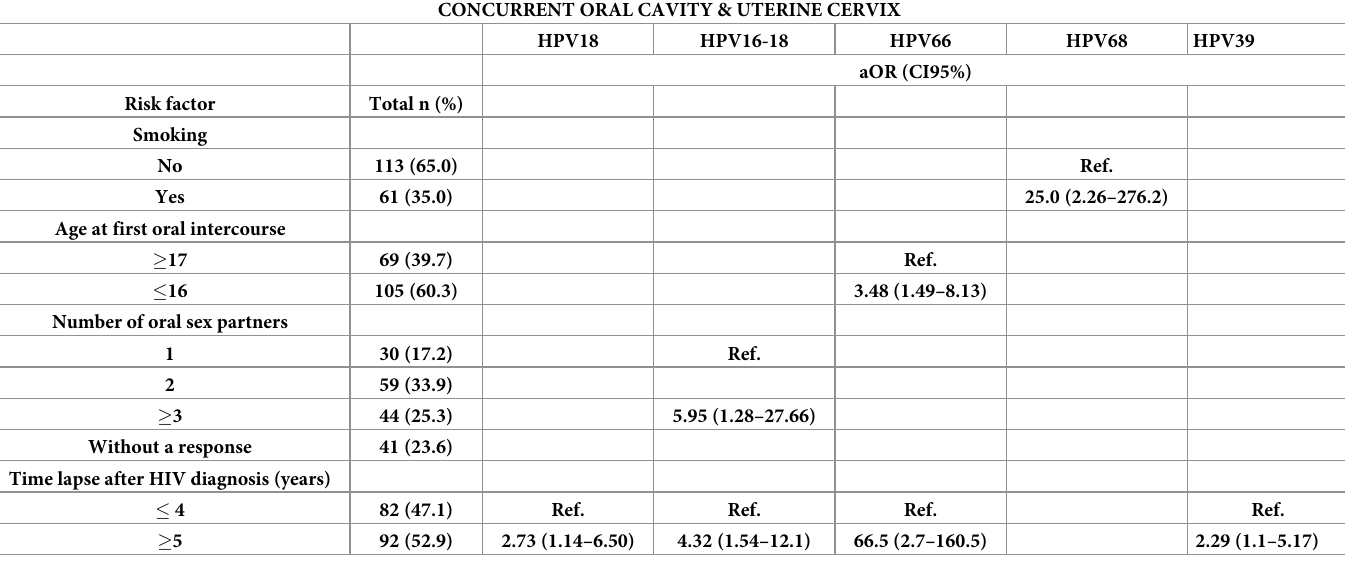
Table 4. Risk of concurrent cervical-oral hrHPV infections associated with sociodemographic and clinical factors (OR = adjusted odds ratio calculated by binary logistic regression; CI 95% = confidence interval at